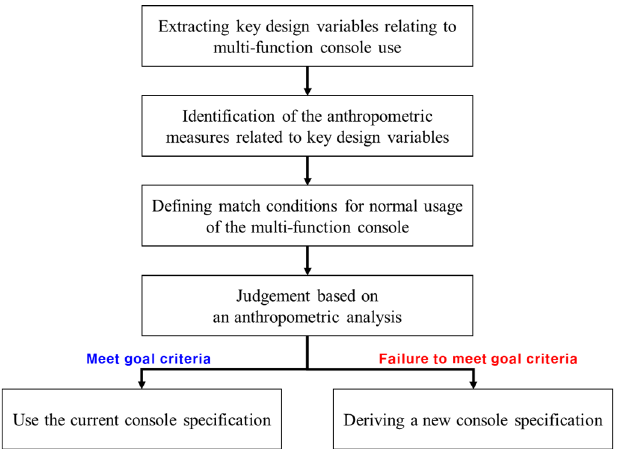
Figure 1. Procedure for design of submarine multi-function console using the anthropometric methodology.